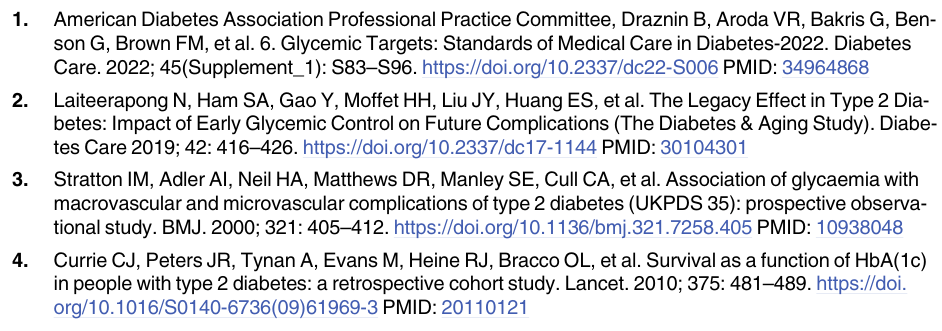
S4 Table. Overall rates and relative hazards of all-cause mortality by different mean HbA1c levels with stratification by anemia and chronic kidney disease staging status. � Inconsistency between total population and population summed for individual variable was due to missing information; HbA1c = glycated hemoglobin; CKD = chronic kidney disease; No anemia: Hb � 13 in men and � 12 g/dL in women; Anemia: Hb < 13 in men and < 12 g/dL in women. † Based on Poisson assumption, CI = confidence interval. ‡ HR = hazard ratio; CI = confidence interval. § p values for the interaction of mean HbA1c with mean hemoglobin and mean estimated glomerular filtration rate were 0.2860 and 0.0022, respectively. || Based on Cox proportional hazard regression with adjustment for general characteristics (i.e., type of diabetes, age and sex). ¶ Based on Cox proportional hazard regression with adjustment for the general characteristics adjusted in Model 1 plus antidiabetic, antihypertensive, and antilipid medications. # Based on Cox proportional hazard regression with all covariates included in Model 2 plus comorbidities, complications, and laboratory